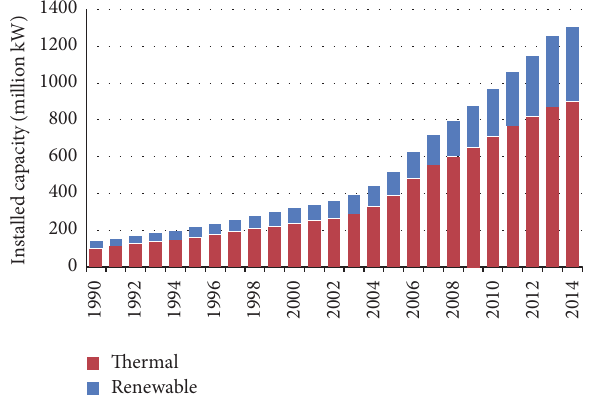
Figure 5: Installed capacity in China’s power sector during 1990– 2014.